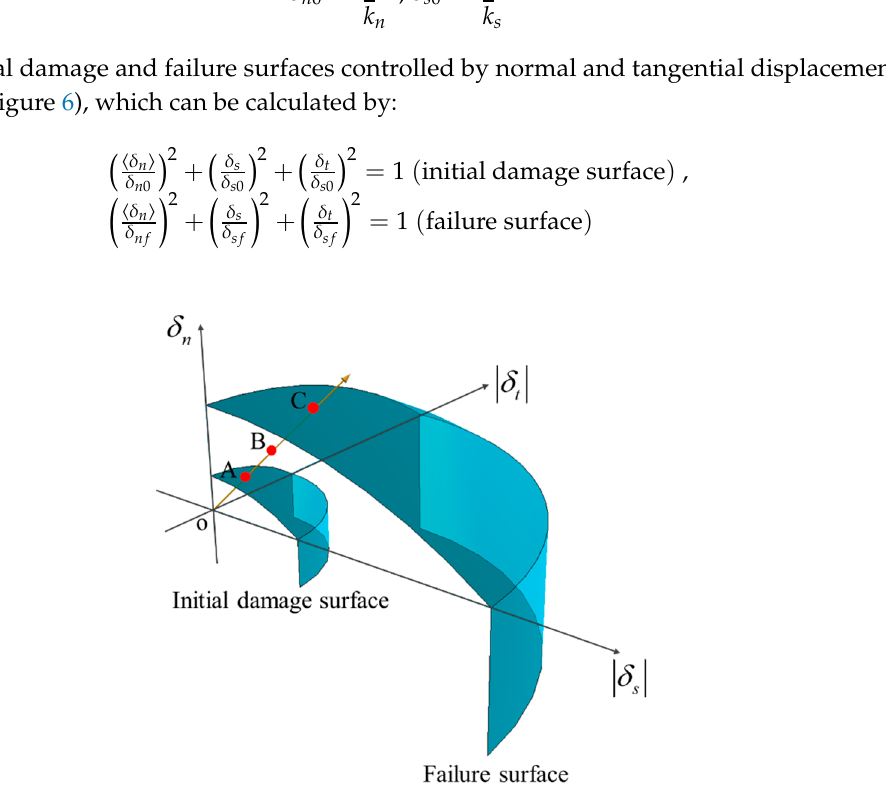
Figure 6. Initial damage and failure surfaces, and the relative displacement points: point B as the historic maximum displacement point, point A as the intersection point of vector OB and the initial damage surface, point C as the intersection point of vector OB and the failure surface.